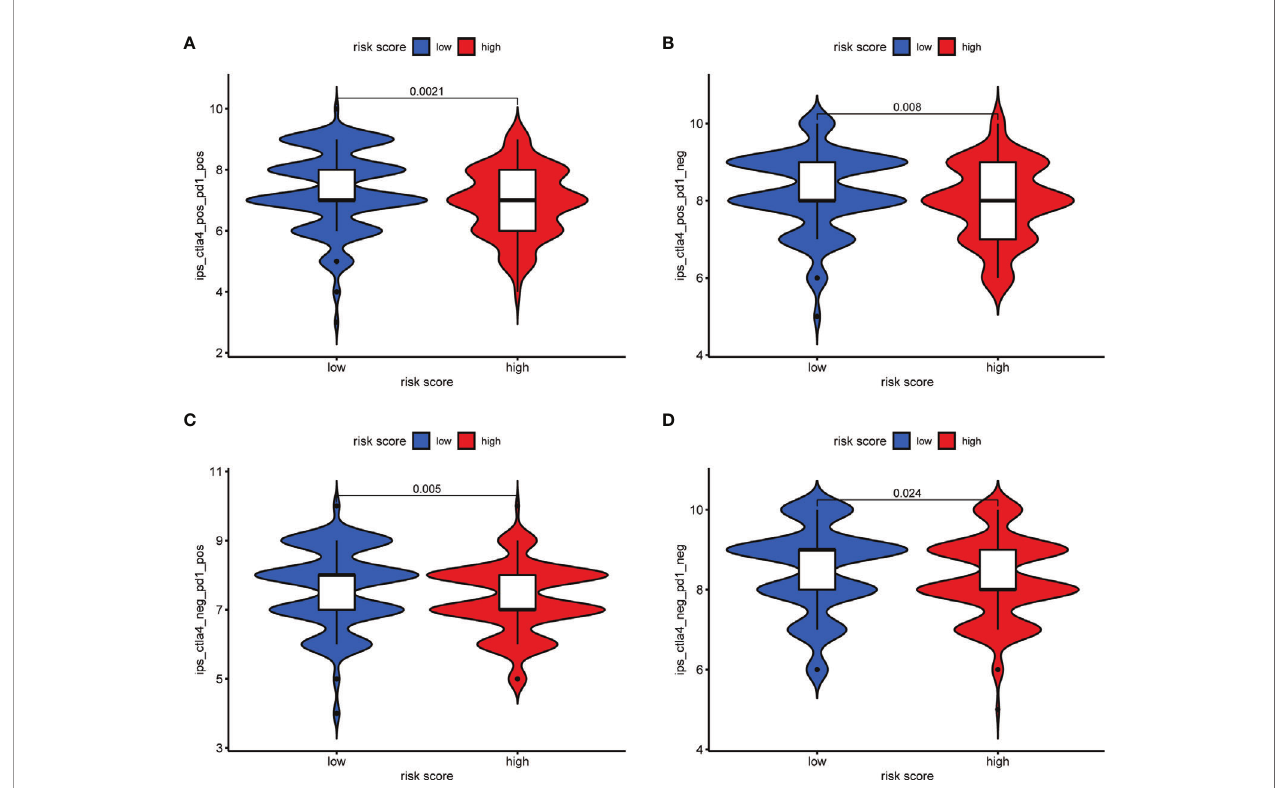
FIGURE 10 | The relative probabilities to respond to anti-PD-1/PD-L1 and anti-CTLA-4 treatment in the low-risk score and high-risk score group. (A) IPS-PD1 (+)/CTLA4(+). (B) IPS-PD1( − )/CTLA4(+). (C) IPS-PD1(+)/CTLA4( − ). (D) IPS-PD1( − )/CTLA4( −